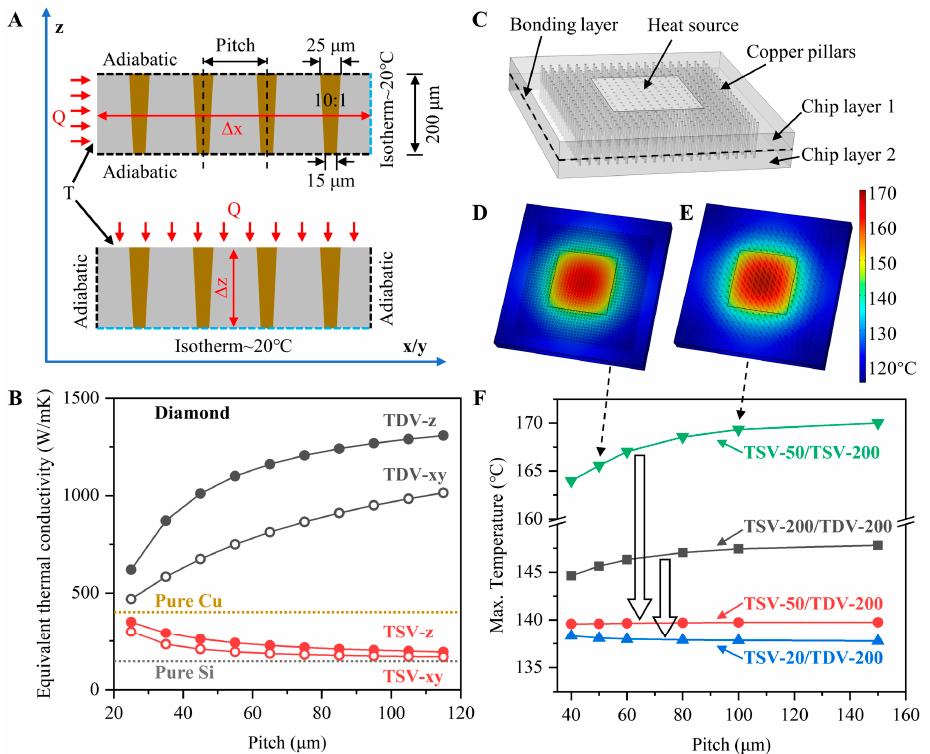
Figure 8. ( A ) Equivalent thermal conductivity model of the Cu-filled chip. ( B ) Relationship between the Cu-filled TSV/TDV anisotropic thermal conductivity and pitches. ( C ) Schematic of the TSV/TDV chip cooling package. Modeled temperature distribution for the two Cu-filled TSV chips with the pitch of ( D ) 50 µ m and ( E ) 100 µ m, respectively. ( F ) Relationship between the maximum temperature and different pitches with different chip layer thicknesses.